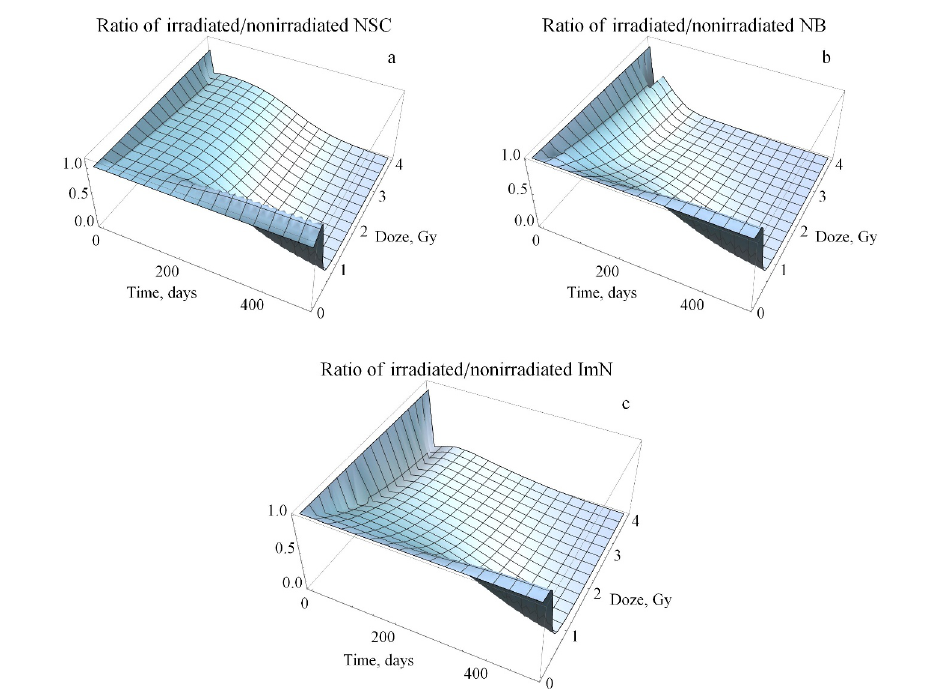
Figure 1. Modeling dynamics of hippocampal neurogenesis after acute exposure to di ff erent doses of 600 MeV / u iron ion radiation for neuronal cell populations: a) neural stem cells, b) neuroblasts, c) immature